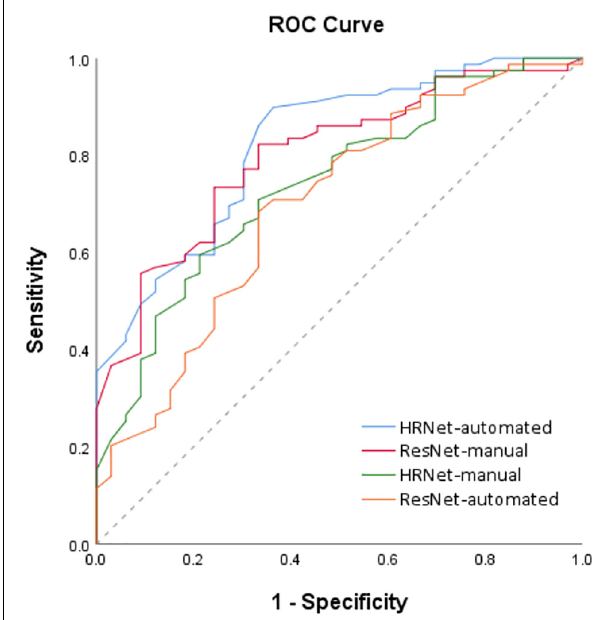
FIGURE 5 | ROC analysis of the 4 models based on the PET-CT images. Receiver operating characteristic (ROC) curves for the four deep learning models (i.e., HRNet-automated, HRNet-manual, ResNet- automated and ResNet-manual) based on the PET-CT images. The area under the ROC curve (AUC) of the HRNet-automated, HRNet-manual, ResNet-automated, and ResNet-manual models were 0.781 (95% CI = 0.755–0.834), 0.789 (95% CI = 0.761–0.906), 0.652 (95% CI = 0.582–0.737), and 0.743 (95% CI = 0.680–0.842), respectively.